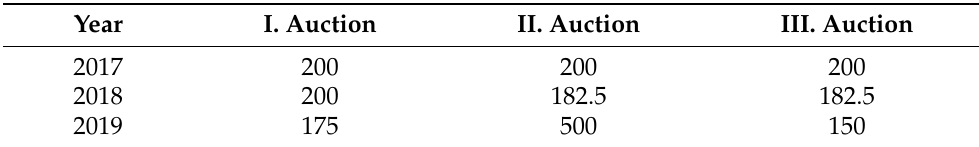
Table 3. The capacity constraints on the German PV auction (in MW), in 2017, 2018 and 2019, source: [44].